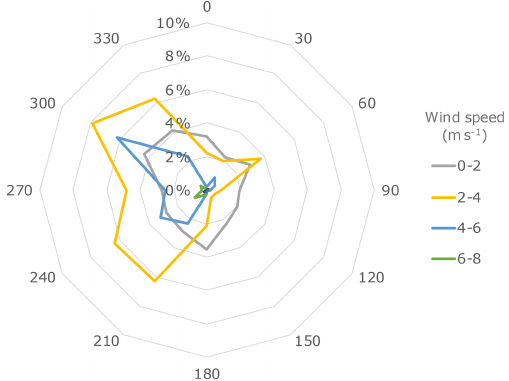
Figure 2. Wind rose for Alqueva-Montante meteorological station from June to September